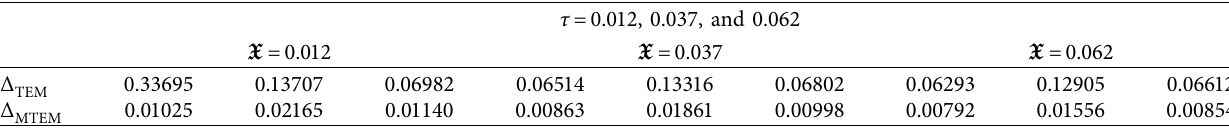
Figure 6: 3D with the imaginary and the real part of solutions Ψ X � 0 . 062 and different values of α . Table 5: Calculation of the difference between solutions Ψ